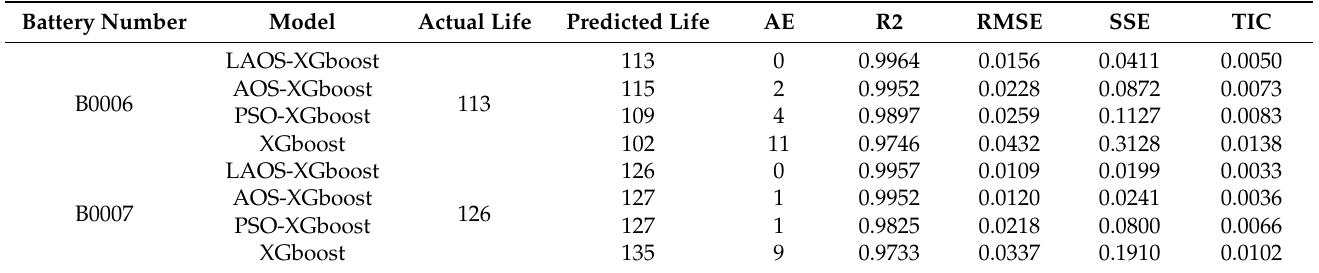
Table 2. Evaluation indicators of various